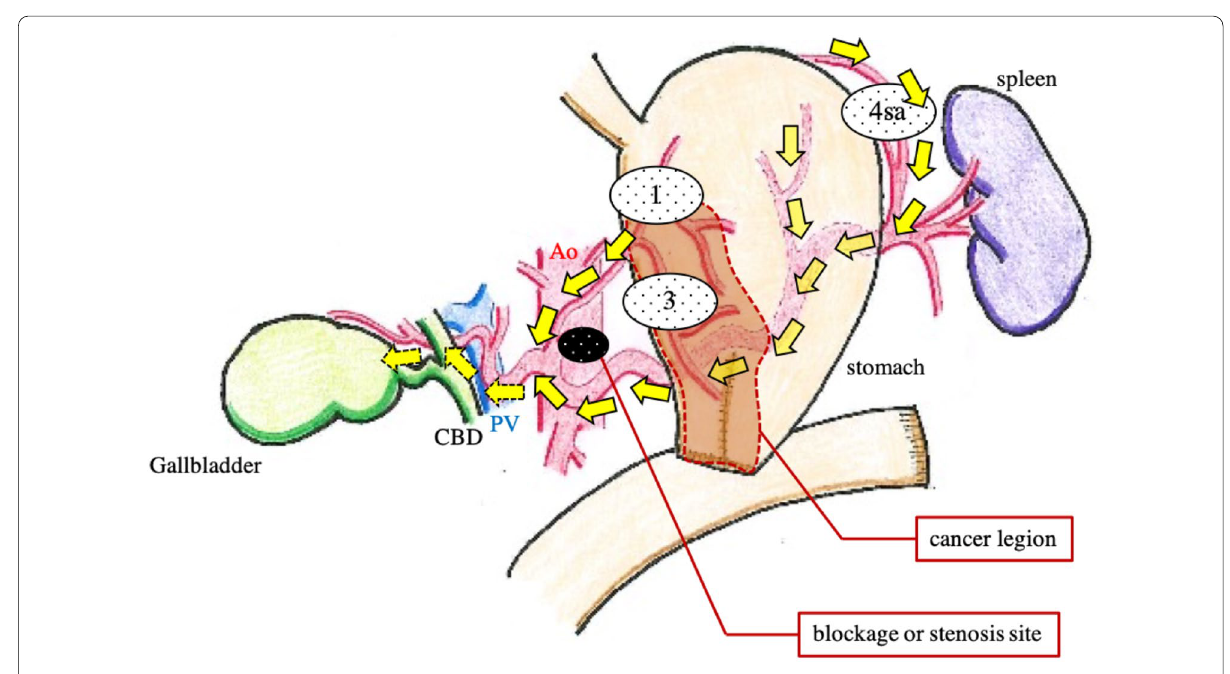
Fig. 6 The speculated pathway of metastasis from gastric cancer to gallbladder. The black circled area is blockage or stenosis site in the lymphatic vessels. Imaginary abnormal lymphatic backflow shown with the dotted